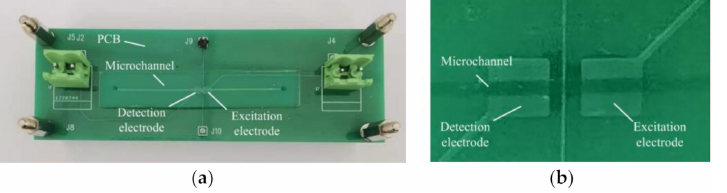
Figure 2. ( a ) The construction of the microfluidic device. ( b ) The photograph of electrodes and microchannel in the microfluidic device.